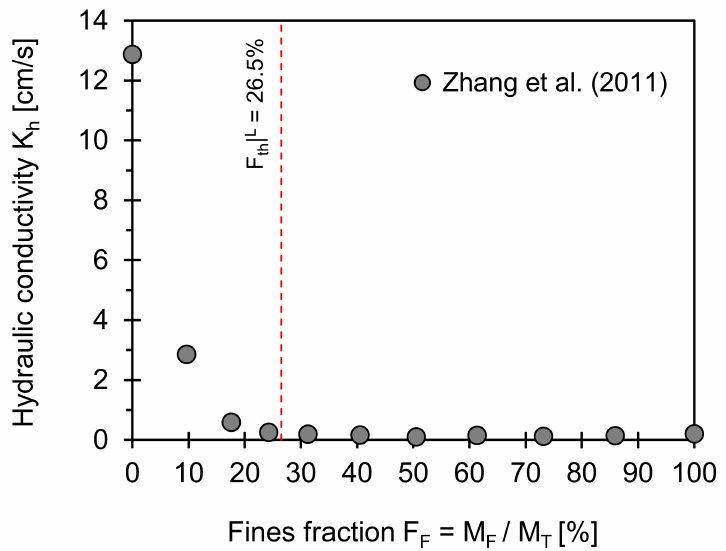
Figure 5. Hydraulic conductivity versus fines fraction. Red dotted lines indicate low threshold fines fraction computed using Equation (2). Input parameters used for estimation of two boundaries are e Cmin = 0.45 and e Fmax = 1.51, and F th | L = 26.5%. Note: Data extracted from Zhang et al.